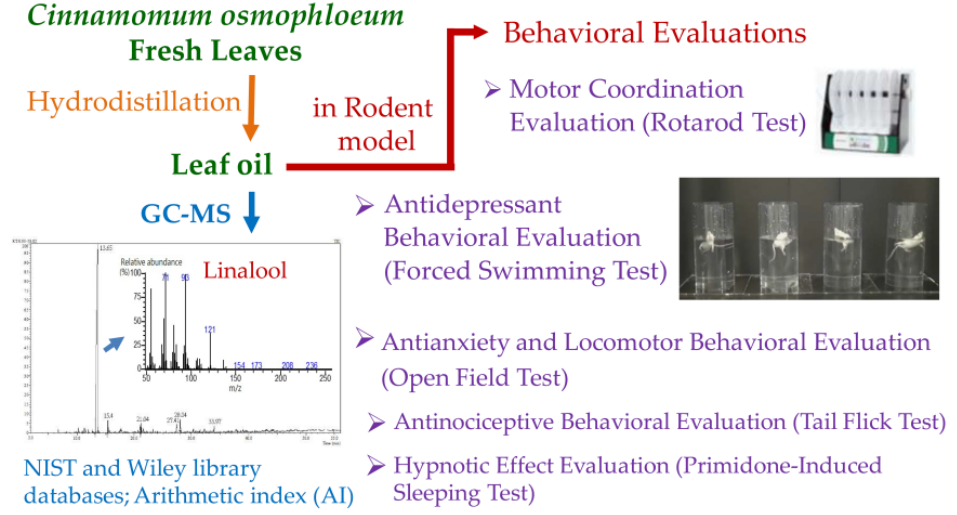
Figure 1. Schematic illustration of constituent analysis and behavioral evaluations of C. osmophloeum ct. linalool leaf oil.